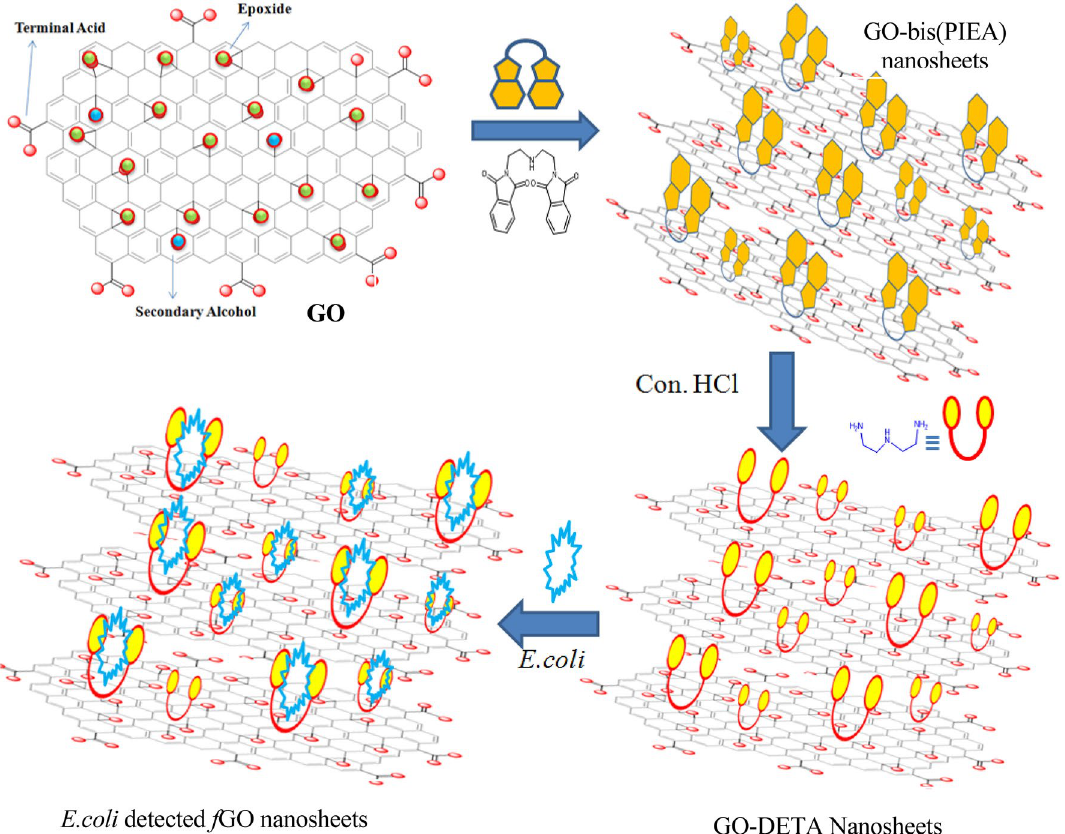
Figure 1. Schematic illustrations of amine functionalized GO for sensing application.